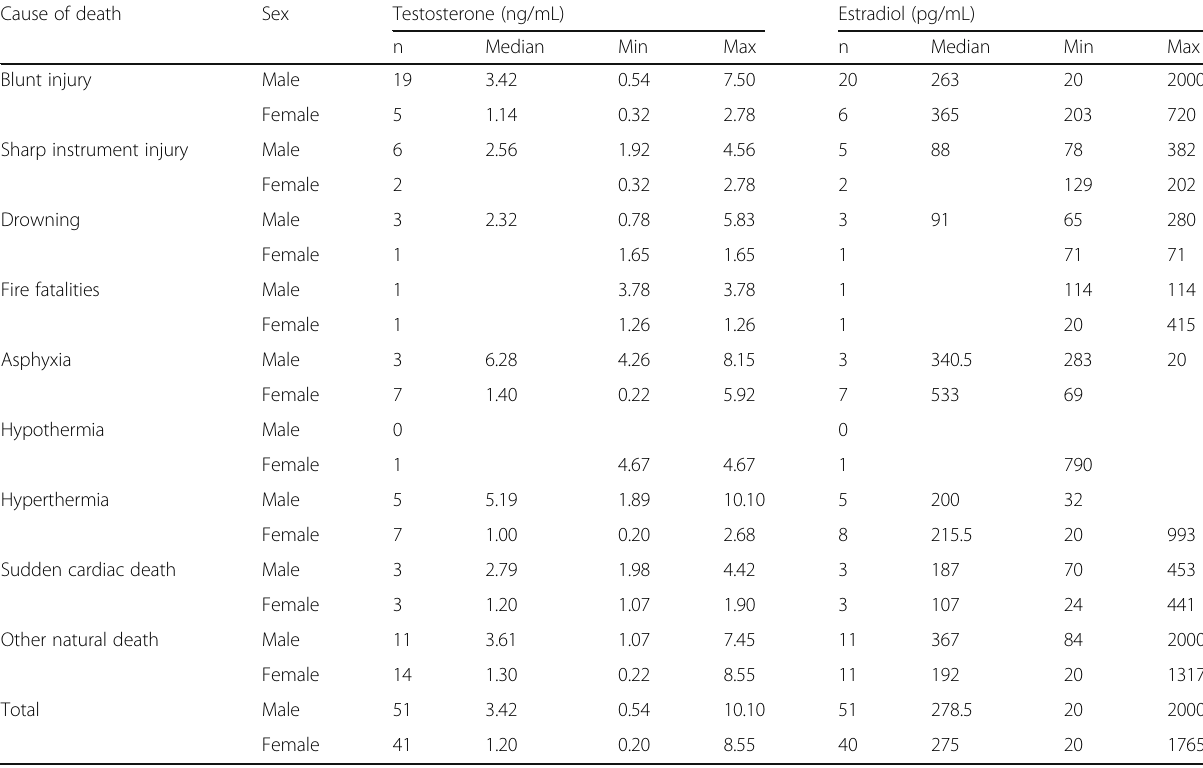
Table 4 Serum concentrations of testosterone and estradiol in the right heart Cause of death